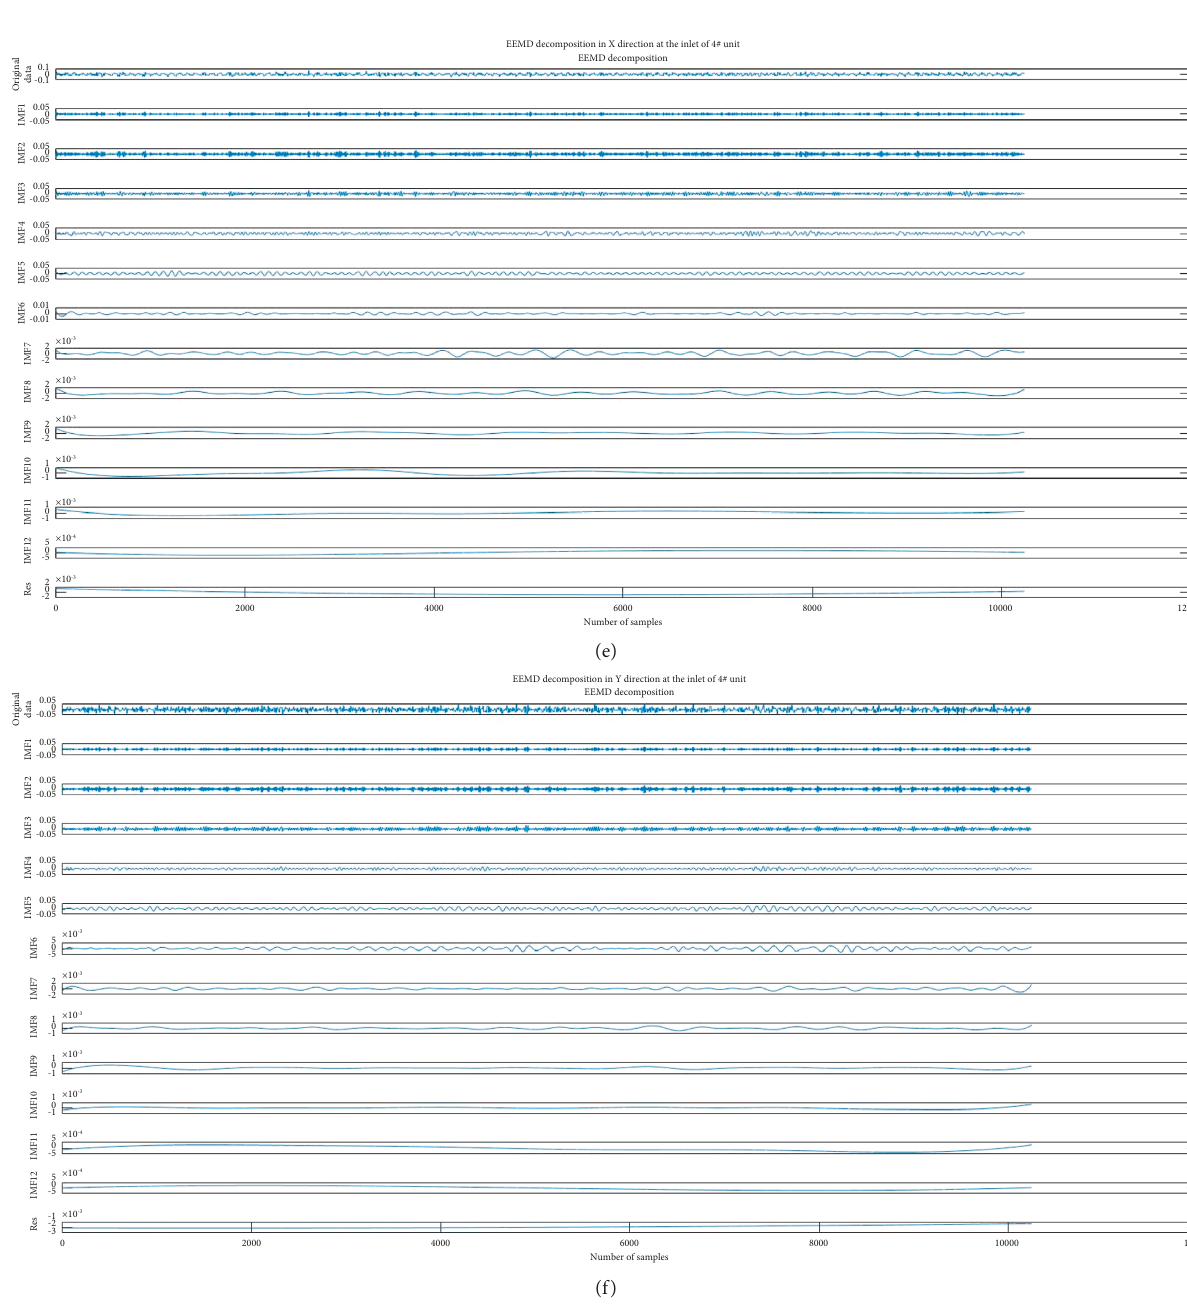
Figure 6: Decomposition waveform of vibration signal after denoising by EEMD. (a) X direction at the inlet of 1# unit; (b) Y direction at the inlet of 1# unit; (c) X direction at the inlet of 3# unit; (d) Y direction at the inlet of 3# unit; (e) X direction at the inlet of 4# unit; (f) Y direction at the inlet of 4#